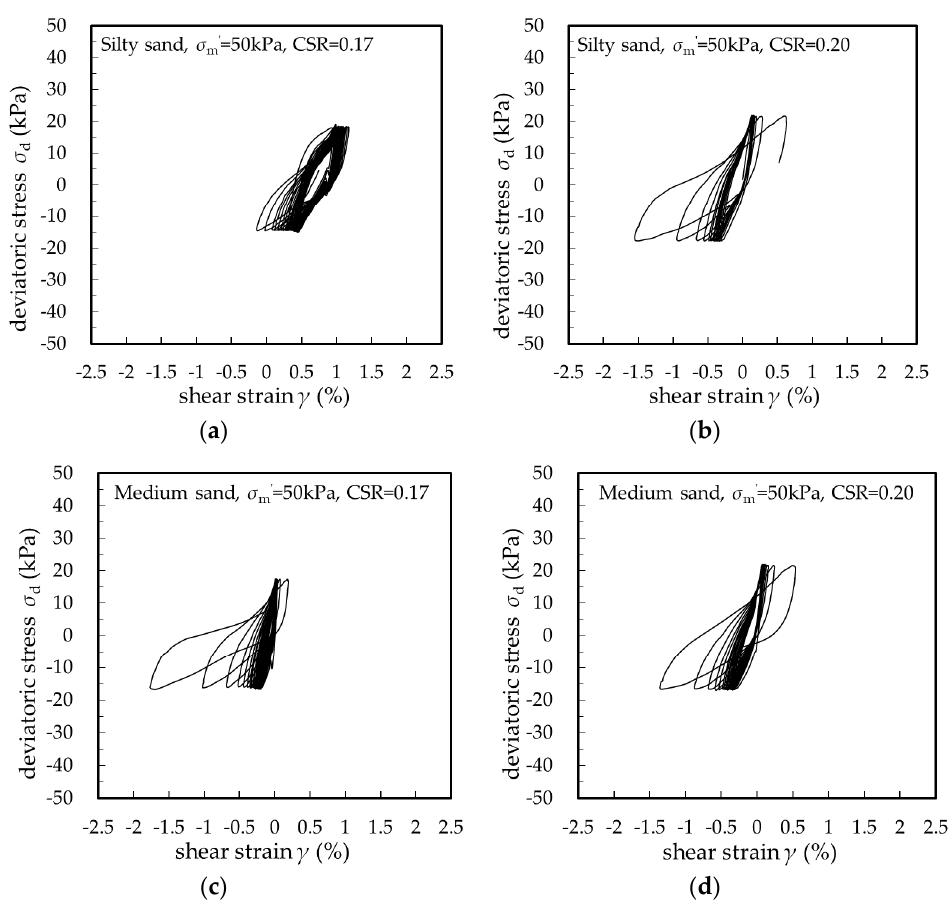
Figure 8. Deviatoric stress-strain curves of different soil types and different CSR: ( a ) Silty sand, CSR = 0.17; ( b ) Silty sand, CSR = 0.20; ( c ) Medium sand, CSR = 0.17; ( d ) Medium sand, CSR = 0.20.